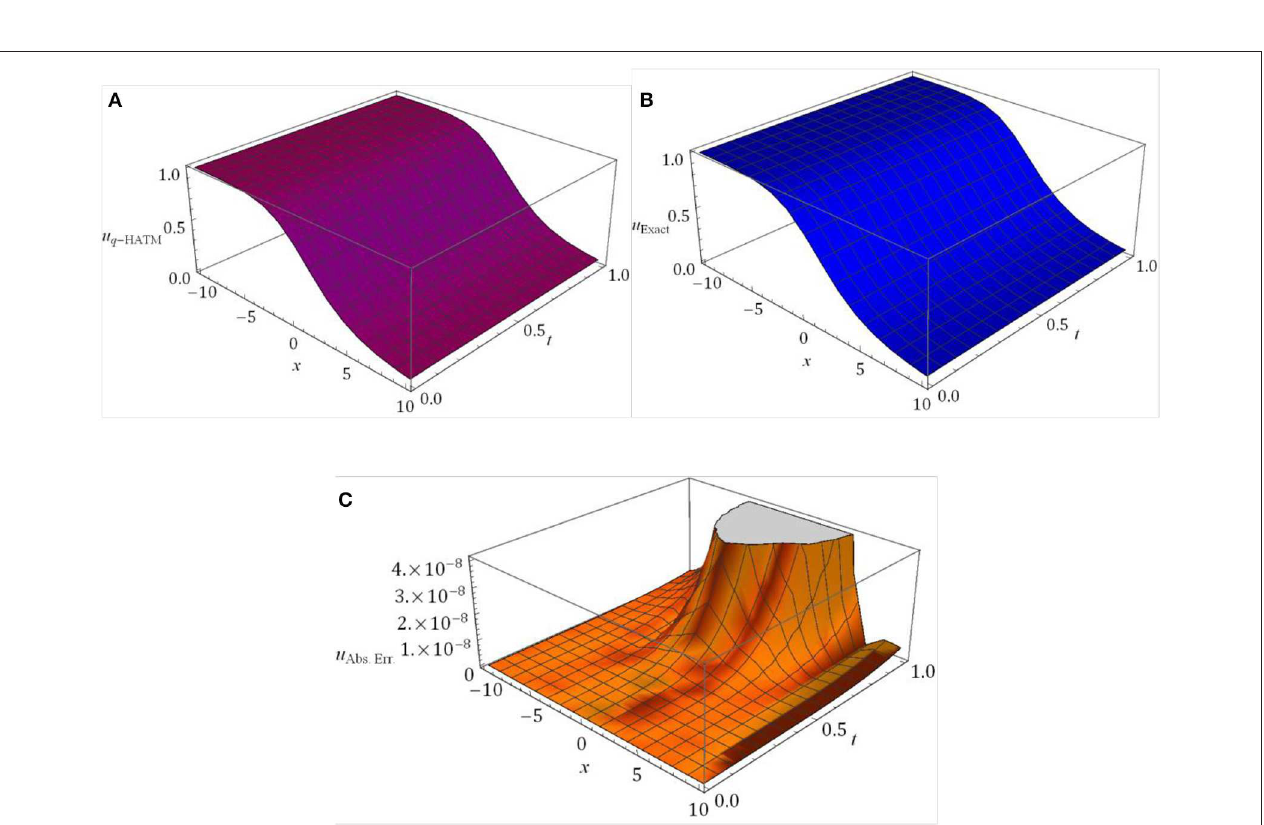
FIGURE 1 | Surfaces of (A) u q − HATM , (B) u Exact (C) u Abs . Err . =